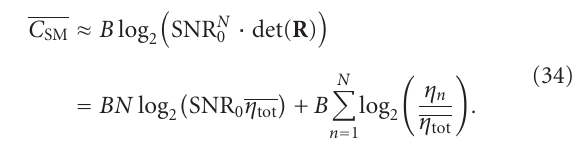
Figure 5: Test setup for, for example, a 2 × 2 MIMO scheme using two dual-polarized test antennas. The AOAs Ω i and Ω j are independently selected on the unit